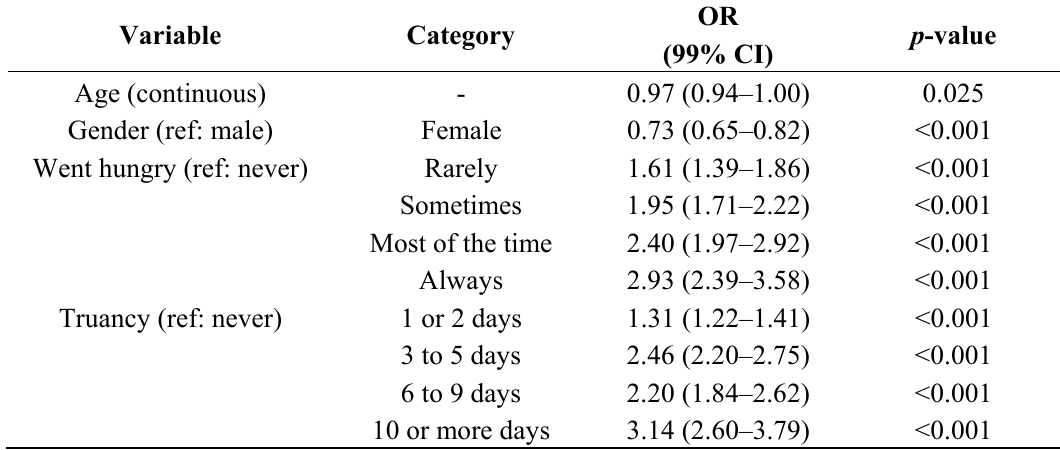
Table 4. Fixed variables that explain differences in bullying at the individual level among 15 low- and middle-income countries (2006–2008). OR, odds ratios; CI, confidence interval.